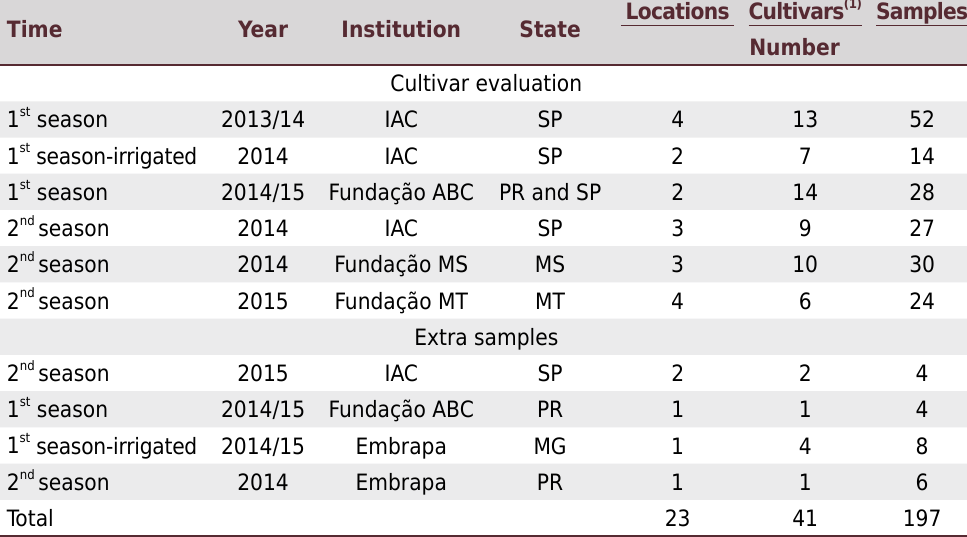
(1) Common cultivars evaluated at all locations, except for the extra samples, which were obtained in soil management tests; total number of cultivars is lower than the sum of the column because some cultivars are common to seasons and/or